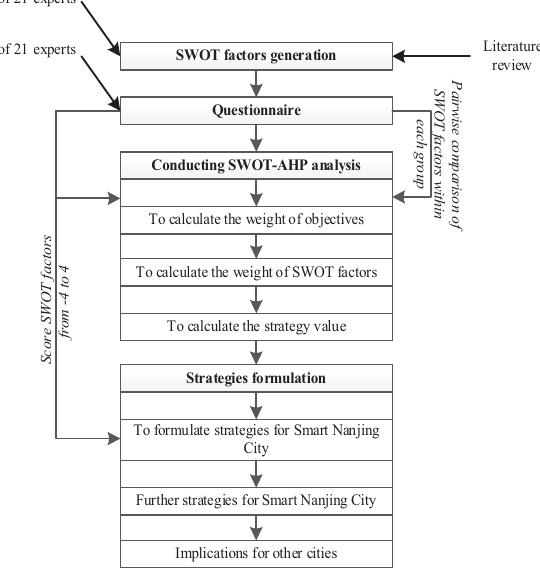
Figure 2. The procedure to formulate